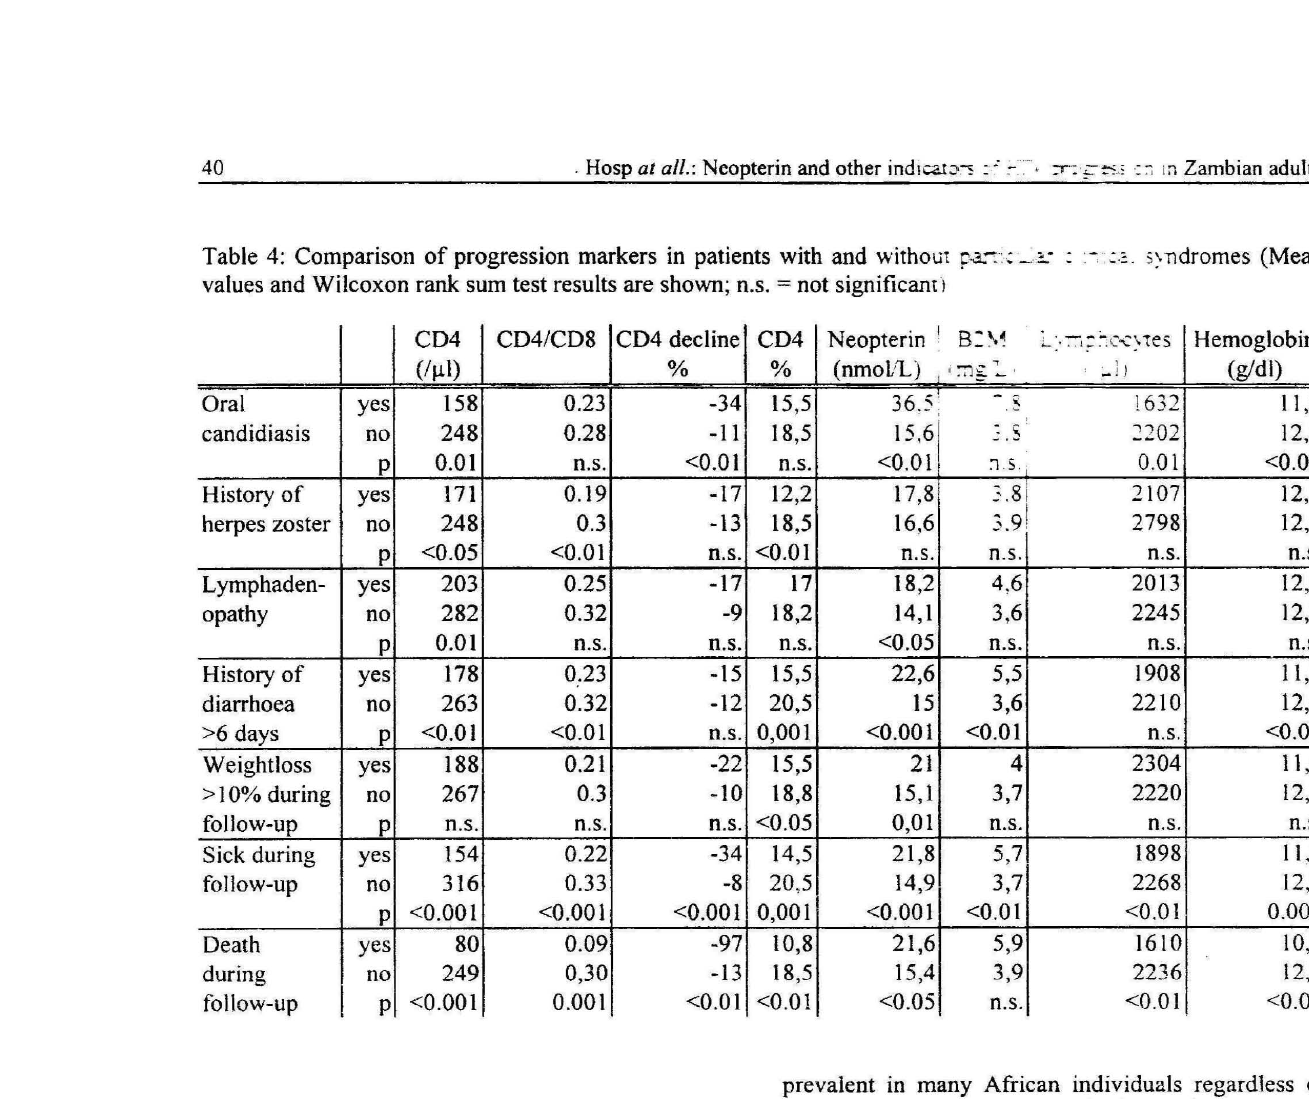
Table 4: Comparison of progression markers in patients with and withom pa:-::~ _~­ values and Wilcoxon rank sum test results are shown; n.s. = not significantl CD4 CD4/CD8 CD4 decline L:.-:-:-,: '-:c..::ytes Hemoglobin